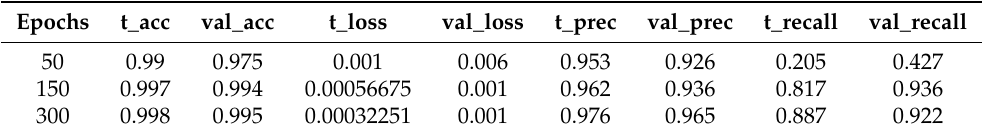
Table 2. Results for the model with focal